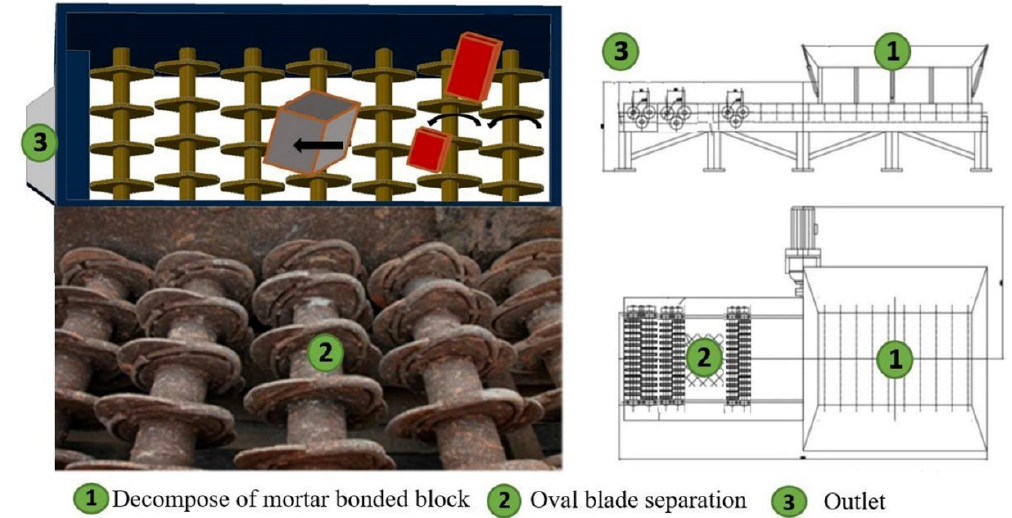
Figure 2. Functional principle illustration of brick separation technology based on shape characteristics.